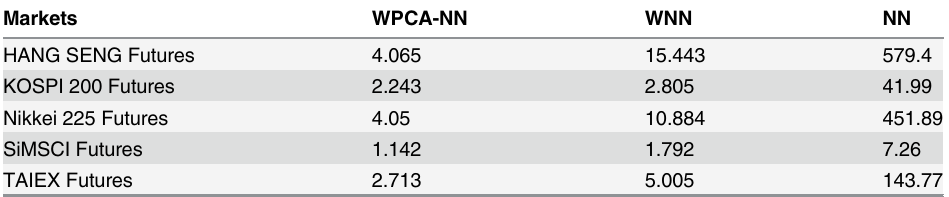
Table 13. Summary of forecasting performance, MAPE ratio, from 2005 to 2014. Markets